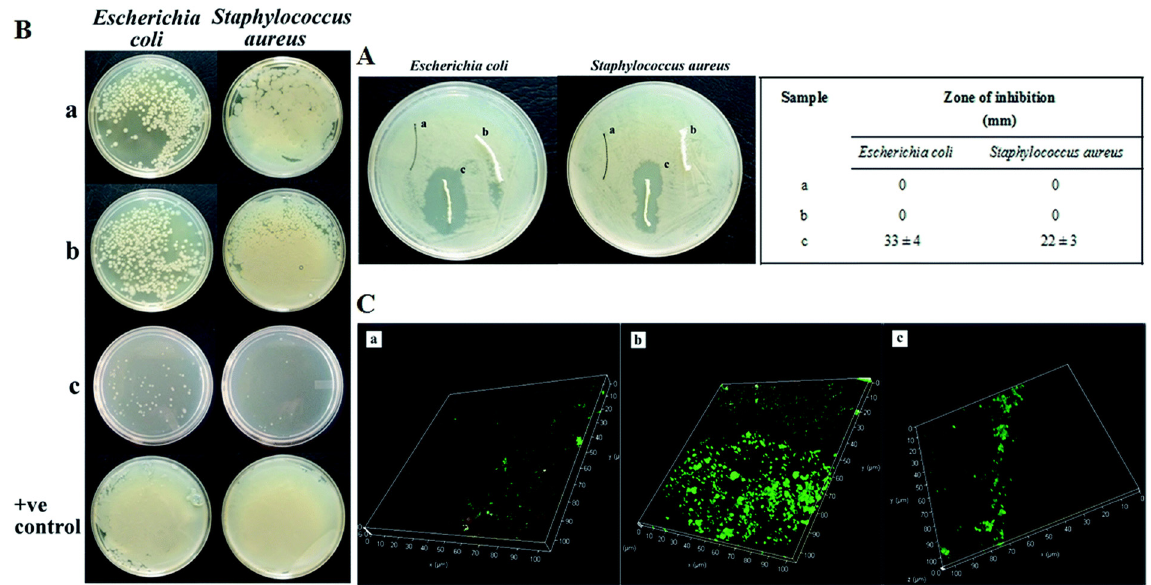
Figure 5. BMSF antimicrobial activity test results. ( A ) Standard agar test, ( B ) re-cultured colonies of tested bacterial strain on agar plates, and ( C ) confocal microscopic examination showing viability of the bacteria ( S. aureus ) on the respective sutures. (Reprinted with permission from Ref. [59]. Copyright 2017 Royal Society of Chemistry.)